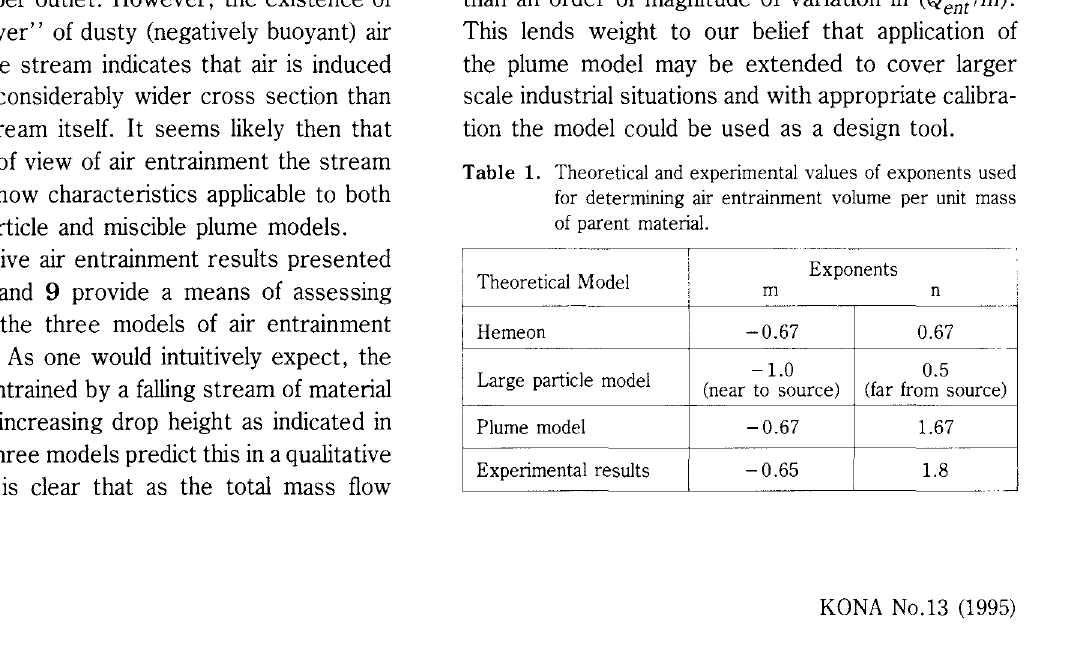
Table 1. Theoretical and experimental values of exponents used for determining air entrainment volume per unit mass of parent